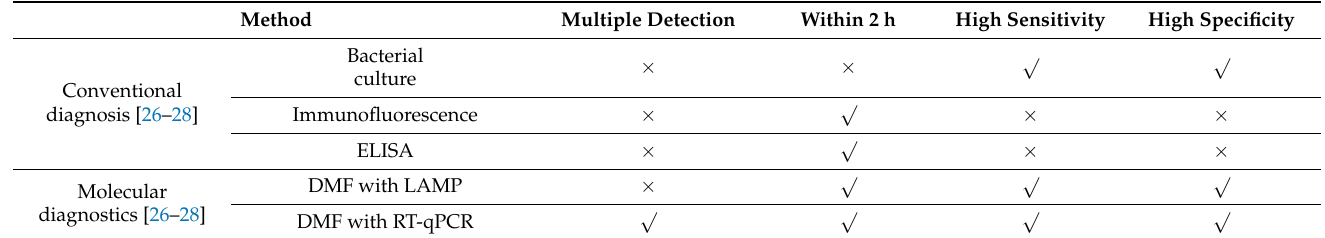
Table 7. Comparison of available diagnostic assays for respiratory pathogens.